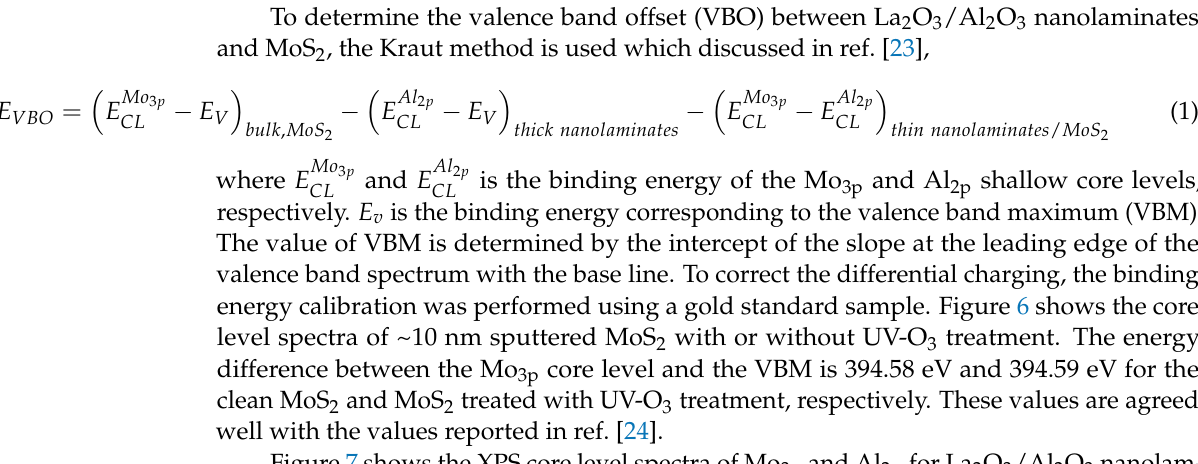
Figure 5. Al 2p spectra of La 2 O 3 /Al 2 O 3 nanolaminates on MoS 2 .